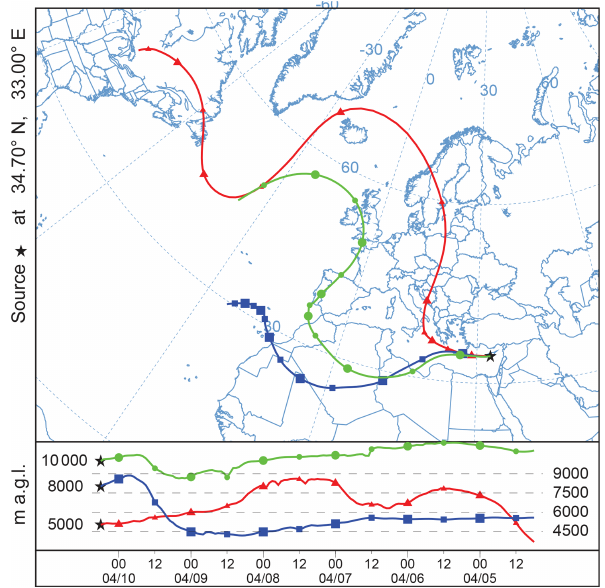
Figure 8. HYSPLIT (Hybrid Single Particle Lagrangian Integrated Trajectory) backward trajectories for 6d arriving at Limassol, Cyprus, on 10 April 2017 at 06:00UTC. The backward trajectories are computed with the HYSPLIT model (HYSPLIT, 2019; Stein et al., 2015; Rolph et al., 2017) and are based on GDAS0.5 meteo- rological fields. Arrival heights are 5000m (red, clear air), 8000m (blue, Saharan dust layer), and 10000m (green, dust free upper tro- posphere). See Fig. 7 for